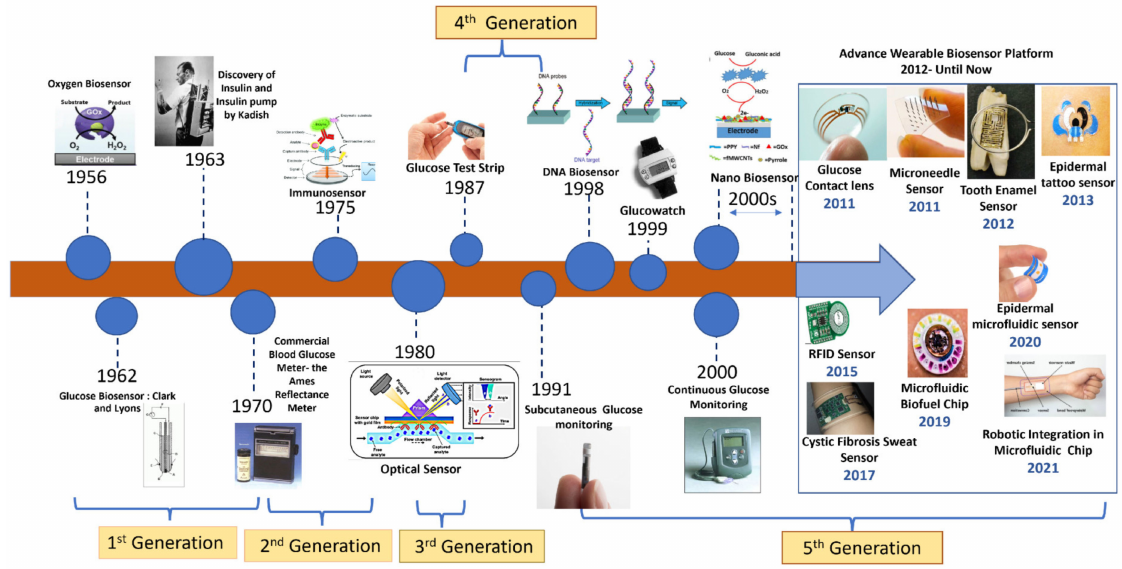
Figure 17. Biosensor development timeline (reprinted from [180], copyright 2022,